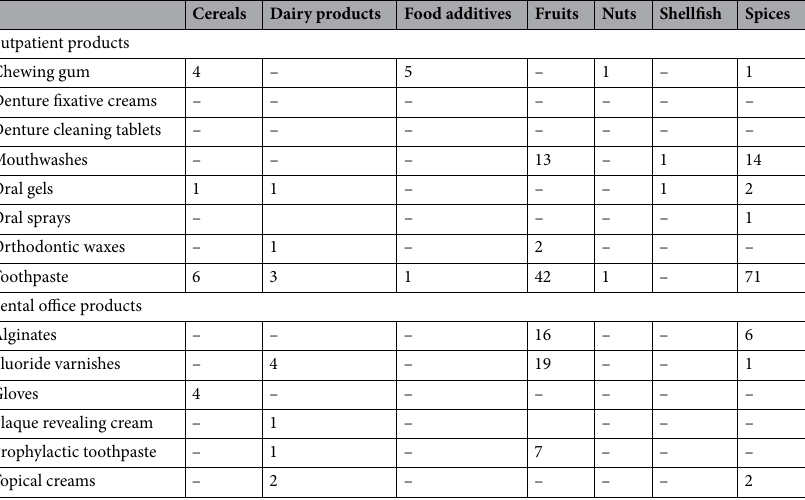
Table 2. Different types of food allergens mentioned in the oral care product labeling.